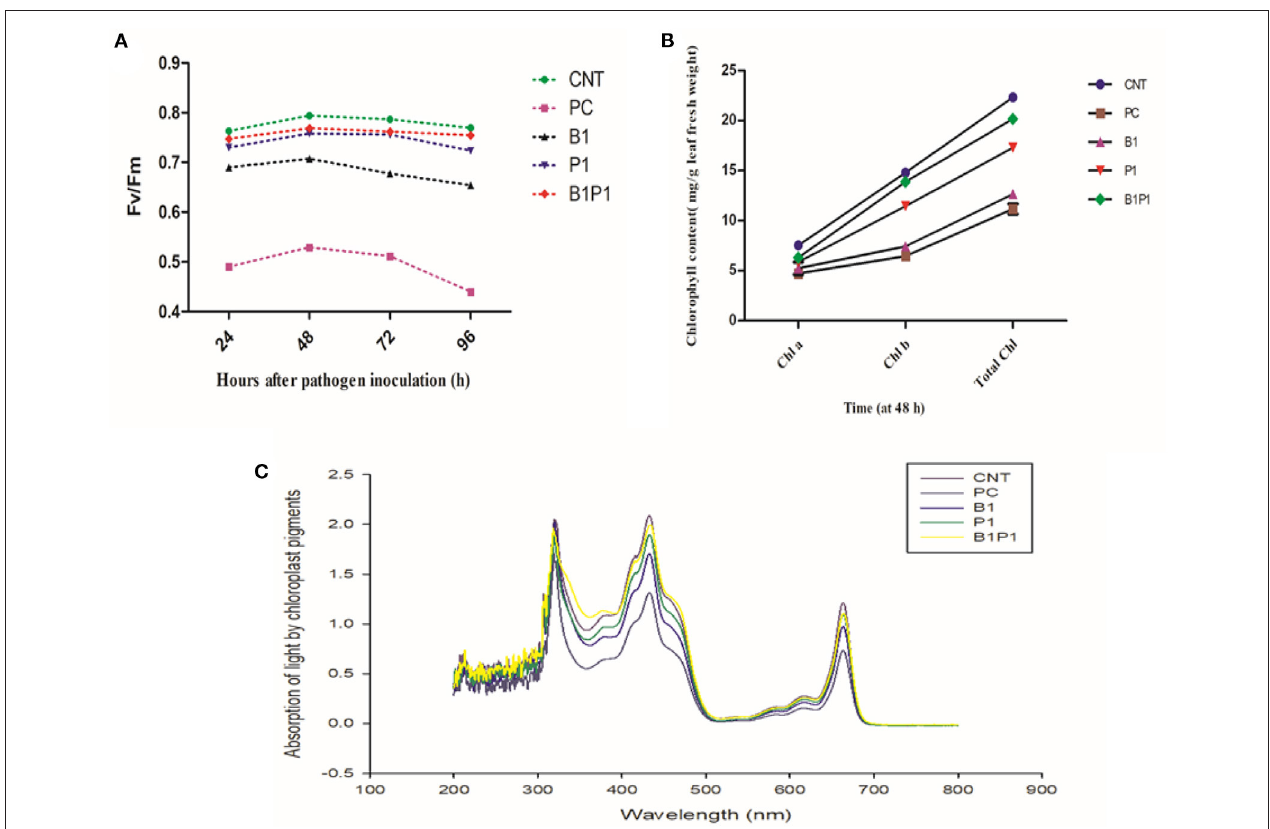
FIGURE 4 | Impact of different treatments on (A) . Photosynthetic efficiency (Fv/Fm); (B) Chlorophyll content (Chl a, Chl b, Total Chl) on tomato leaves at 48h of pathogen inoculation; (C) Absorption spectrum against wavelength (nm) at 48h. Data shown as a mean ± SE ( n = 3). Tukey’s B post-hoc test at 5% confidence level ( p < 0.05) was used to see the significance of data.